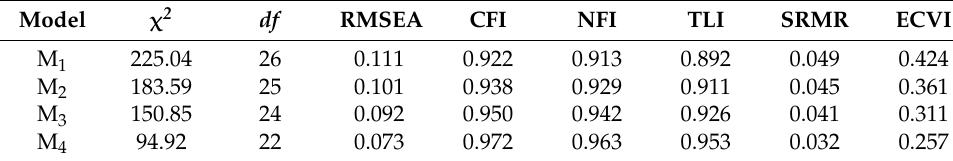
Table 2. Results of confirmatory factor analysis on AESI items ( n =